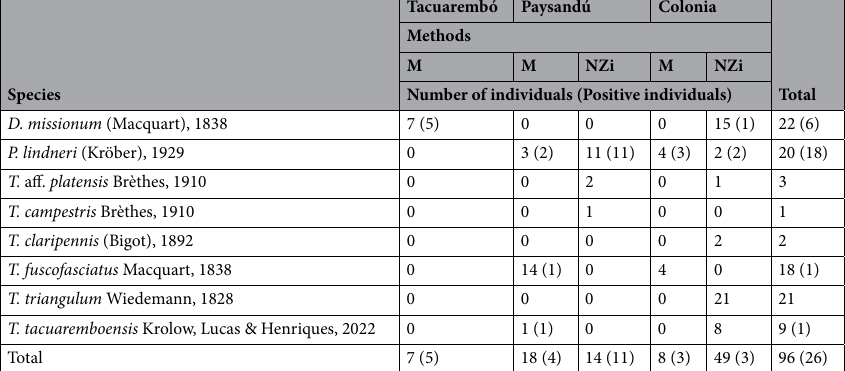
Table 1. Species and total specimens of Tabanidae collected using different methods to detect A. marginale by PCR and Sanger sequencing in the departments of Tacuarembó, Paysandú and Colonia, Uruguay. M, manually; NZi, NZi trap. Number of individuals (positive